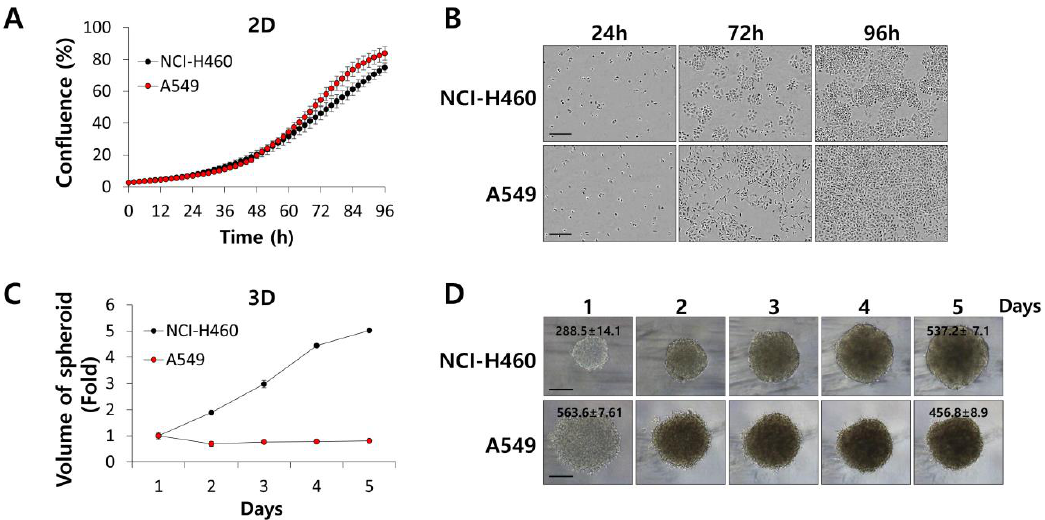
Figure 1. Cell growth was di ff erent in two-dimensional (2D) monolayer culture and three-dimensional (3D) tumorspheroids. ( A , B ) A549 and NCI-H460 cells were plated at a density of 2 × 10 4 cells per well of 96-well plates. Cell confluence was measured every 2 h for 96 h using the IncuCyte live cell analysis system. Representative images of cells were produced at 24, 72, and 96 h. ( C , D ) A549 and NCI-H460 cells were seeded in 96-well ultra-low attachment (ULA) plates and measured by diameter of spheroids at the indicated times. Spheroid volume was calculated as 4 / 3 × π × r 3 . All data are presented as mean ± SD. Spheroid morphology was examined by light microscopy. Representative number is the diameter ( µ m) of spheroids. Scale bars, 200 µm.